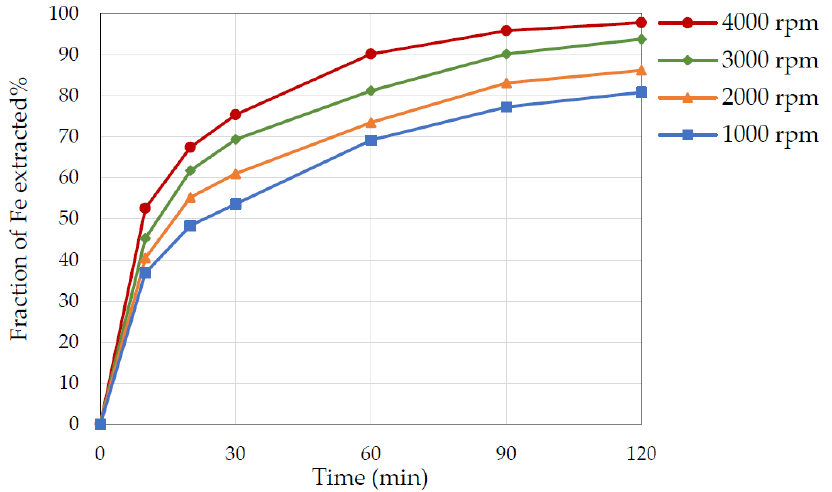
Figure 8. The effect of stirring speed on Fe extraction as a function of time. Conditions: 3 M nitric acid, temperature 65 °C, S/L ratio 1 to 20, particle size +53−75 µm.